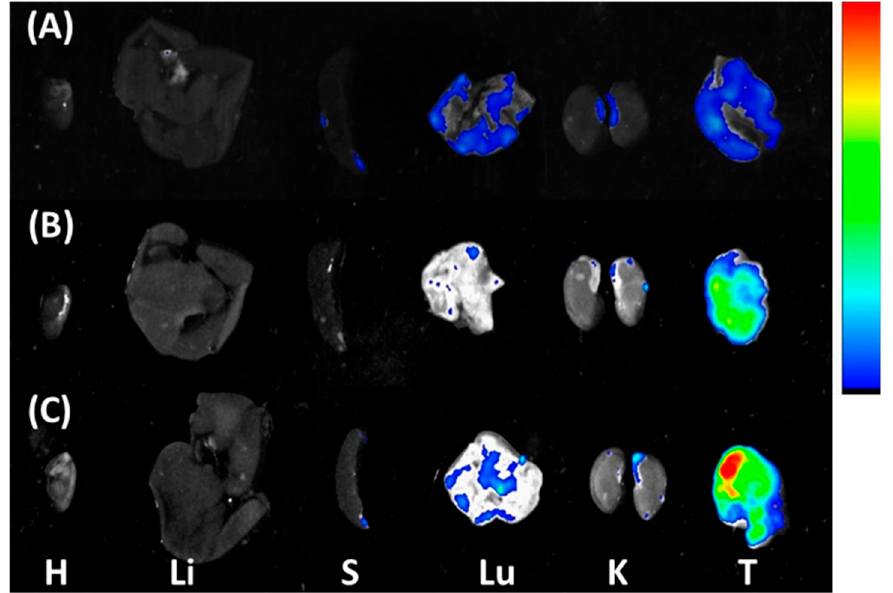
Figure 5. Ex vivo biodistribution in mice at 48 h after treatment with Sunitinib ( A ), Sunitinib micelles ( B ), or SN-38/Sunitinib micelles ( C ) in HCT-116 tumor bearing mice. Distribution of Sunitinib-green in the major tissues of HCT-116 tumor bearing mice: H, heart; Li, Liver; S, spleen; Lu, lung; K, kidney; T, tumor.